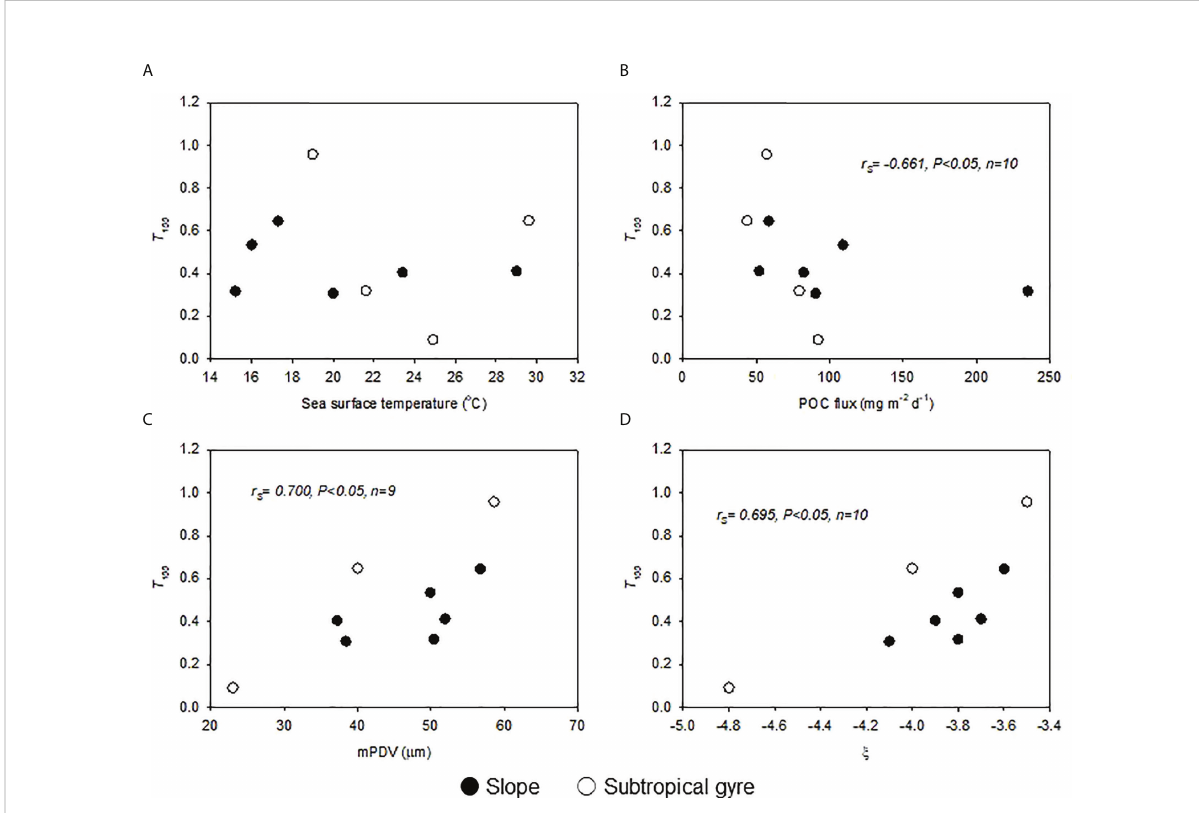
FIGURE 6 Relationships of T 100 with (A) sea surface temperature, (B) sinking fl ux of POC, (C) mean particle diameter of the volumetric particle size distribution (mPD V ), and (D) slope of the regression line of the particle size number distribution. Spearman rank order correlations ( r s ) are